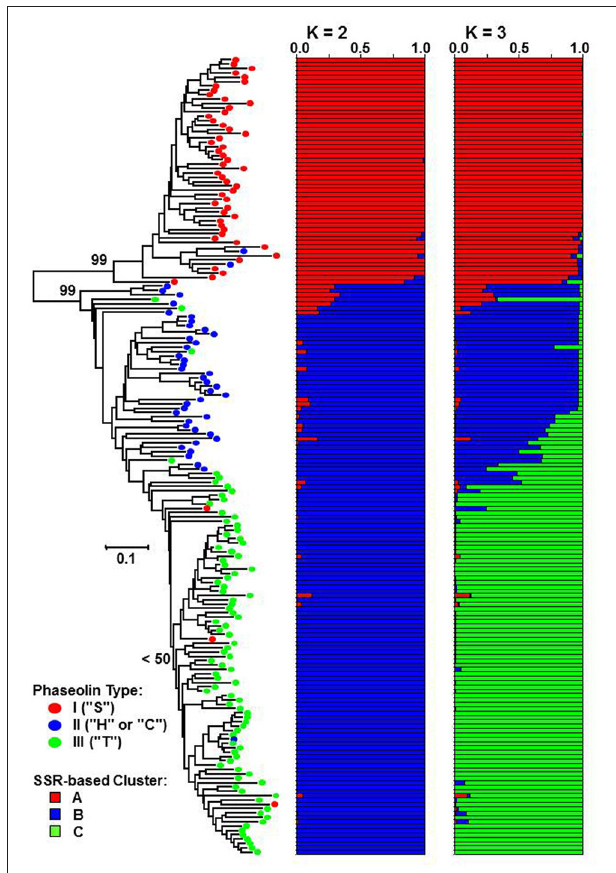
FIGURE 2 | Fitch-Margoliash tree based on proportion-of-shared alleles distance between 183 common bean accessions. Average proportions of membership for K = 2 and 3 clusters are given as estimated by STRUCTURE. Classification based on phaseolin type is indicated on branches of the